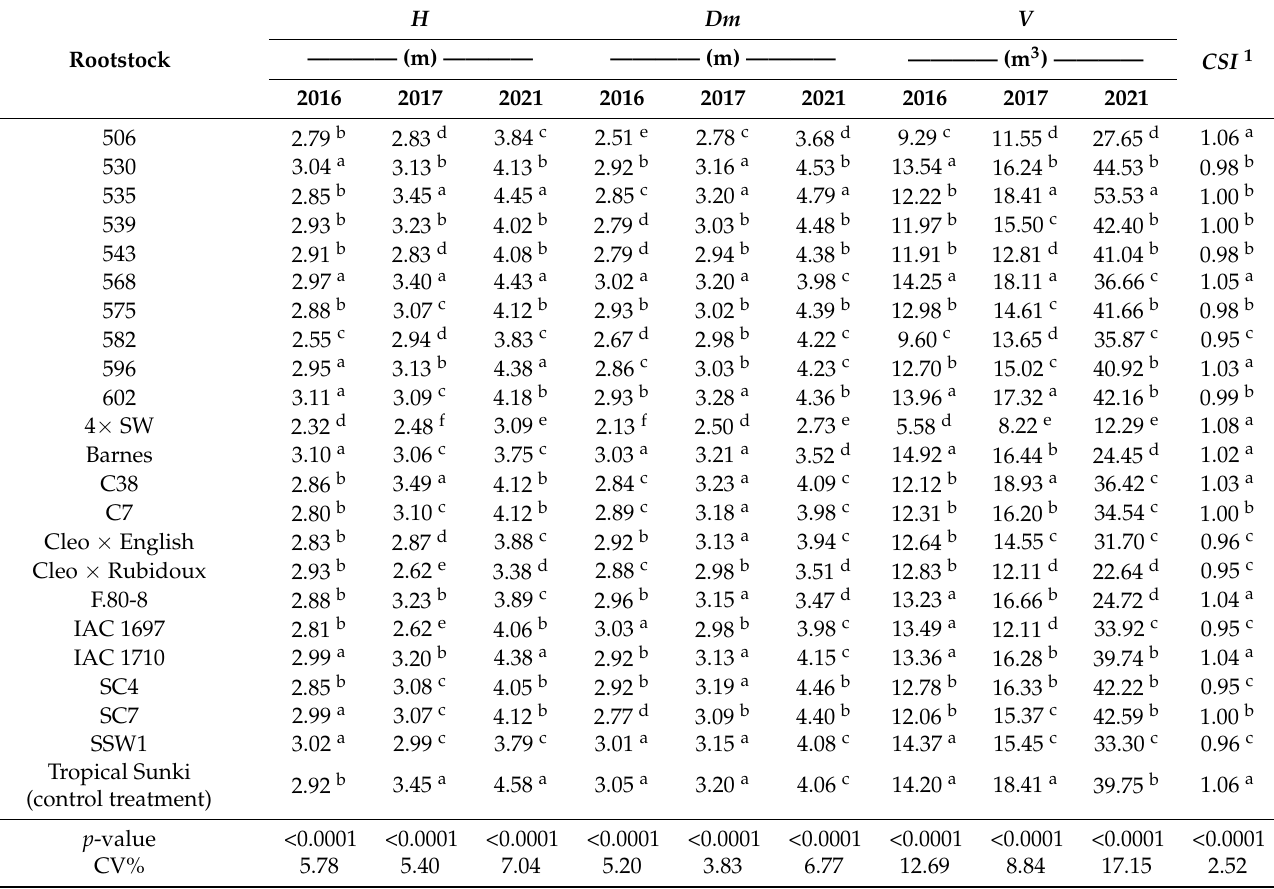
averaged mean of 41.70 m 3 . Only the tetraploid Swingle citrumelo was consistently a true dwarfing rootstock (12.29 m 3 ), decreasing in tree size by 77% in relation to the citrandarin 535. The remaining groups can be classified as semi-dwarfing (Cleopatra × Rubidoux, Barnes, F.80-8 and 506) and substandard (IAC 1697, Cleopatra × English, both citranges, SSW1 and citrandarins 582 and 568), leading to a mean canopy volume of 24.86 m 3 and 34.63 m 3 , respectively. The canopy shape was also influenced by the rootstocks, and can be classified in three groups: vertical ellipsoid or prolate, with CSI > 1 (506, 568, 596, Barnes, 4 × Swingle, C38, F.80-8, IAC 1710 and Tropical Sunki); horizontal ellipsoid or oblate, with CSI < 1 (582, both Cleopatra × trifoliate orange hybrids, IAC 1697, SC4 and SSW1); the ∼ = remaining rootstocks induced spherical or round trees, with CSI 1 (Table 2). Table 2. Tree height ( H ), mean canopy diameter ( Dm ), volume of the canopy ( V ), and canopy shape index ( CSI ) in 2016, 2017 and 2021, five to ten years after the planting of Valencia sweet orange [ Citrus × sinensis (L.) Osbeck] grafted onto 23 rootstocks and cultivated without irrigation in Northwestern S ã o Paulo State, Brazil. H Dm V Rootstock